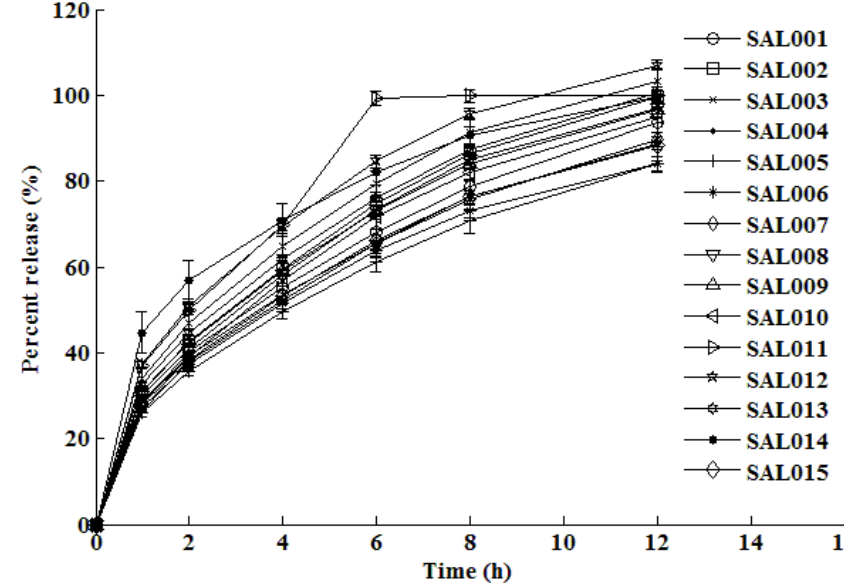
Figure 2. In vitro mean dissolution profiles of formulations SAL001 – SAL015 established from experimental design.